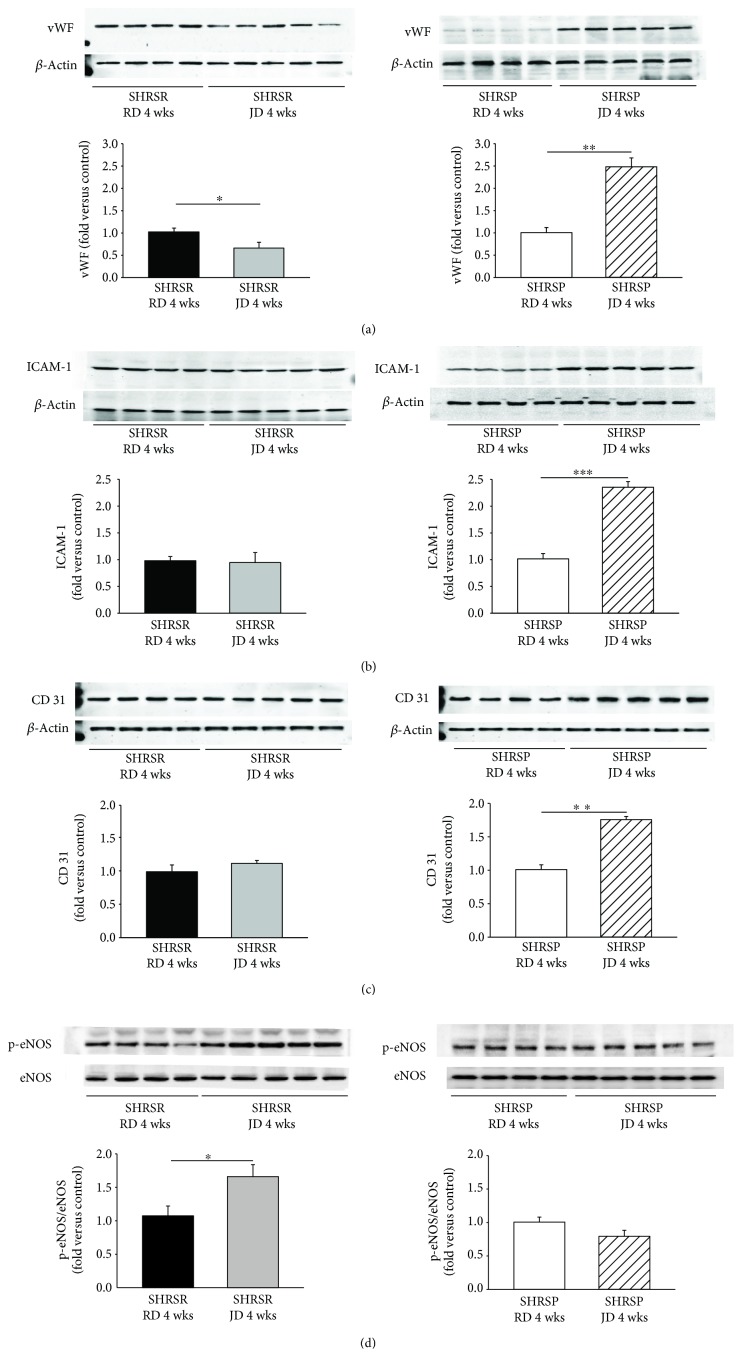
Characterization of protein expression level of vWF, ICAM-1, CD31, and eNOS in the brains of JD- versus RD-fed SHRSR and SHRSP strains. Representative Western blots with corresponding densitometric analysis are shown for the four indicated proteins in the two strains (SHRSR, left side; SHRSP, right side). (a) vWF expression level; ∗p < 0.05 JD- versus RD-fed SHRSR; ∗∗p < 0.001 JD- versus RD-fed SHRSP. (b) ICAM-1 expression level; ∗∗∗p < 0.0001 JD- versus RD-fed SHRSP. (c) CD31 expression level; ∗∗p < 0.001 JD- versus RD-fed SHRSP. (d) eNOS and phospho-eNOS expression level; ∗p < 0.05 JD- versus RD-fed SHRSR. JD = high-salt Japanese style diet; RD = regular diet. N = 8 for each experimental group.